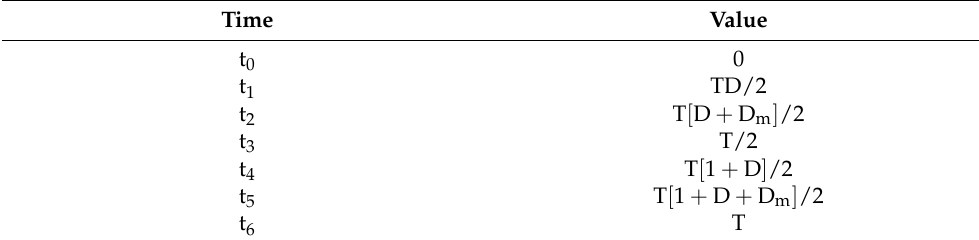
Figure 4. DPS operation ( a ) simulated circuit and ( b ) corresponding waveforms. Table 3. Switching cycle for one period with the DPS control.